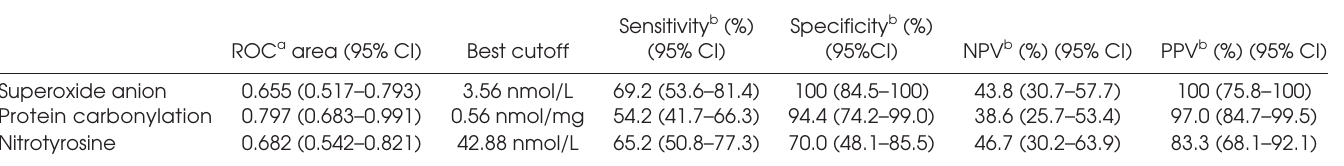
table 4a. Markers with predictive value in blood for LC-COPD with respect to LC patients.